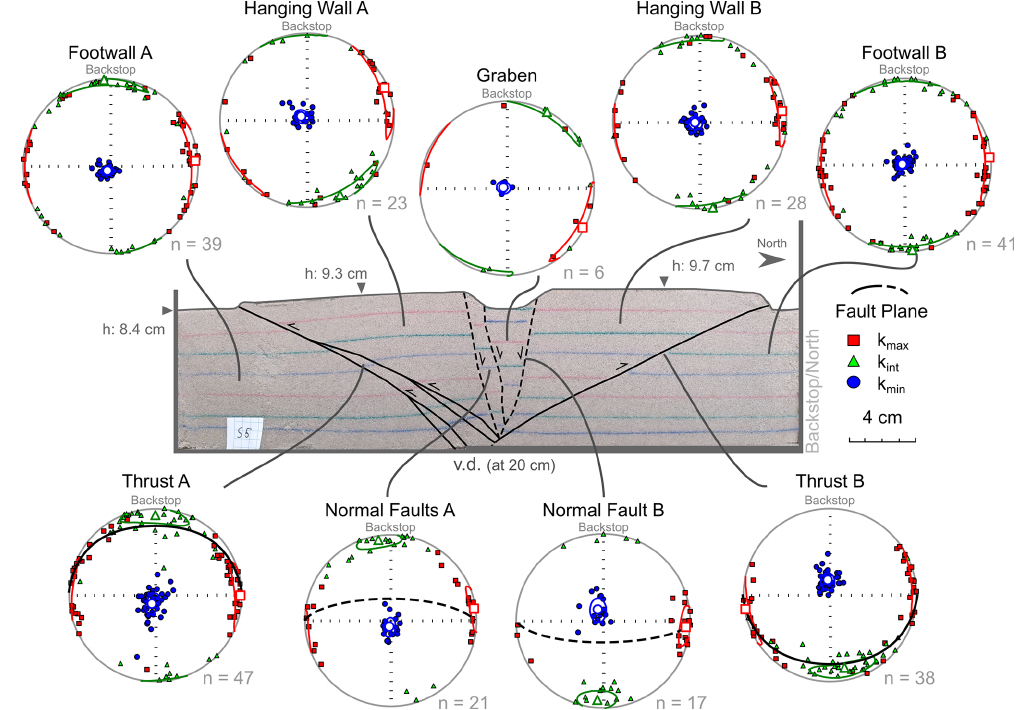
Figure 5. Representative section of Model III showing the main structures and corresponding magnetic fabric plots.